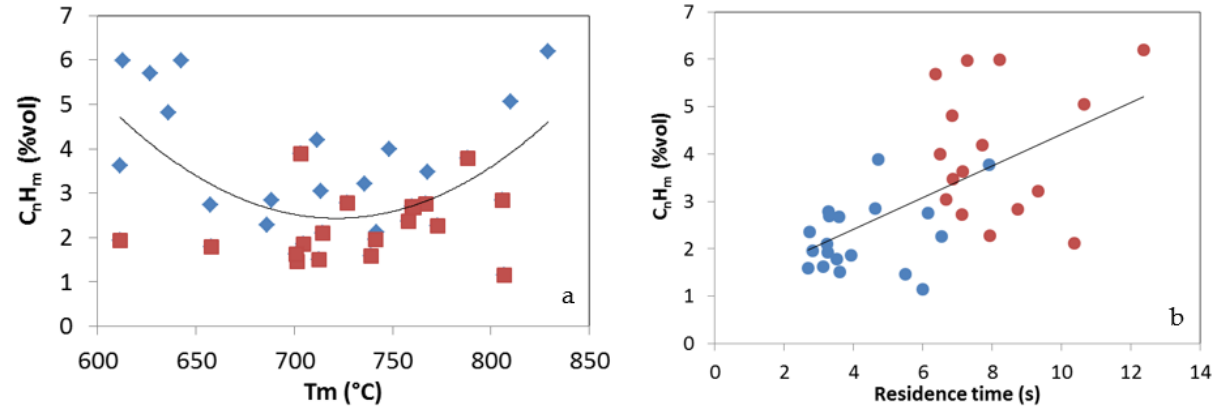
Figure 7. Incondensable hydrocarbons content of syngas as function of the bed average temperature Tm ( a ) and of the residence time of the syngas in the bed ( b ). (C n H m is the sum of CH 4 , C 2 H 6 , C 3 H 8 ). Red symbols correspond to the experimental data of the oxy-gasification; blue symbols data of the air-gasification.